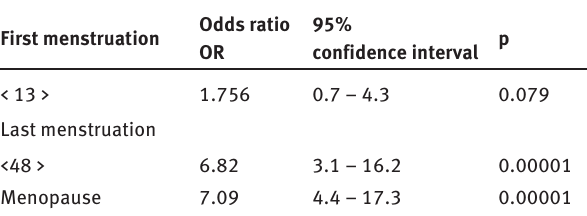
Table 6: The risk of ovarian cancer including the first and last menstruation.